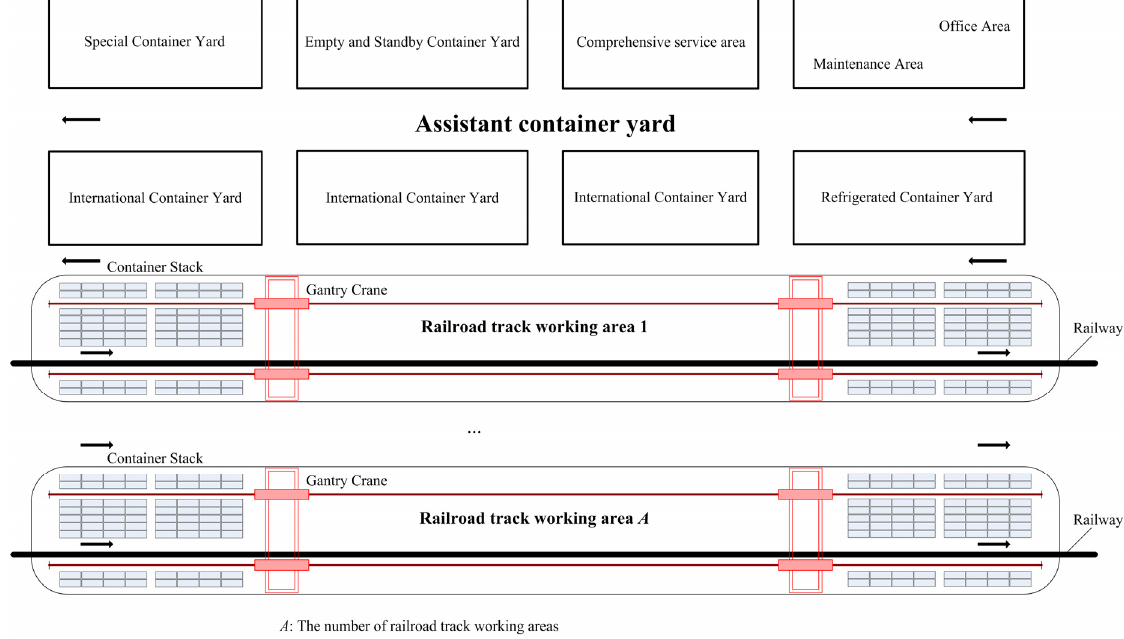
Fig. 1. Schematic Representation of a railway container